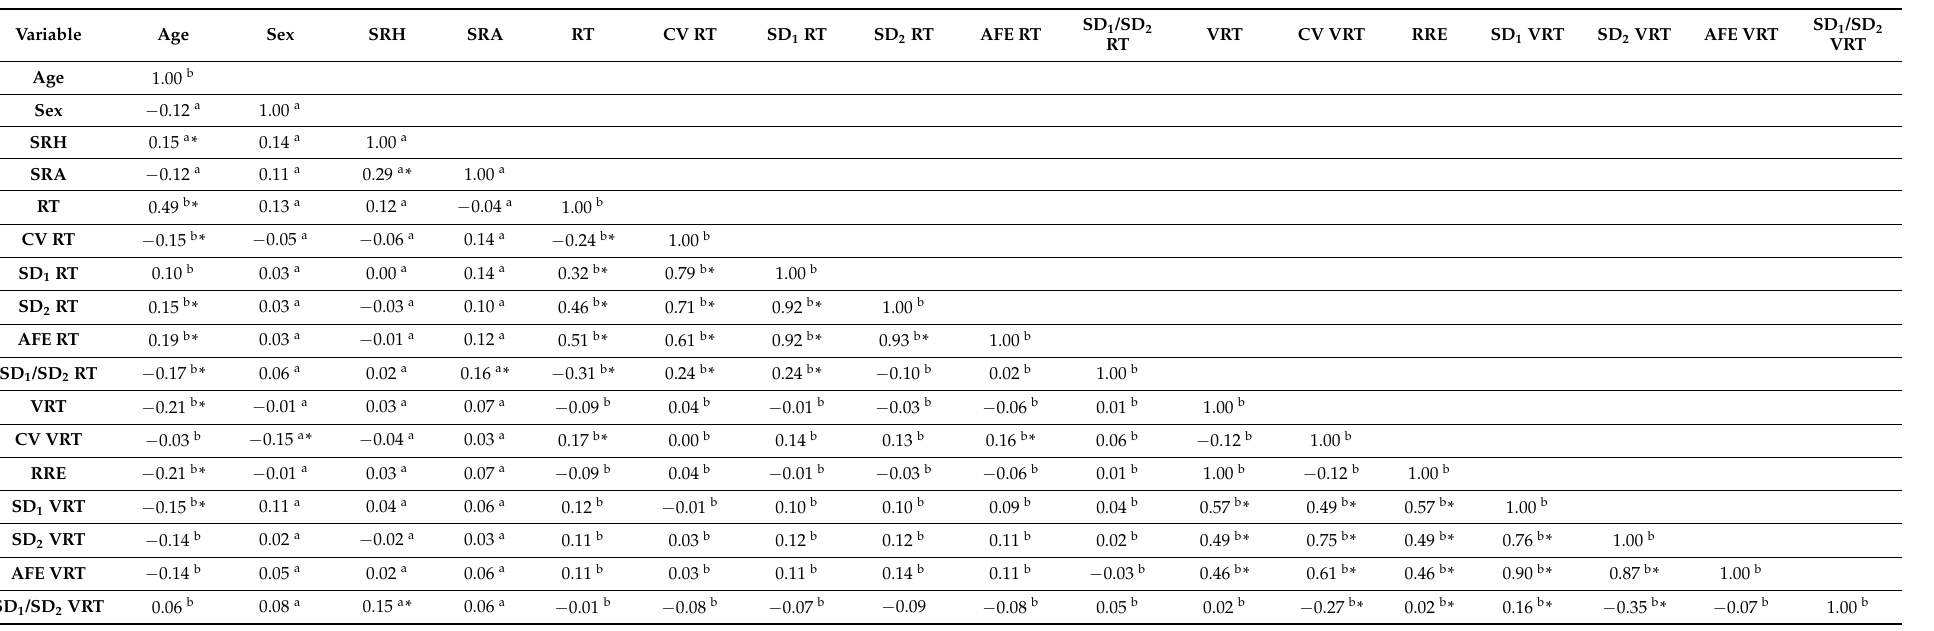
Table 4. Correlation output and level of statistical significance p ( n =